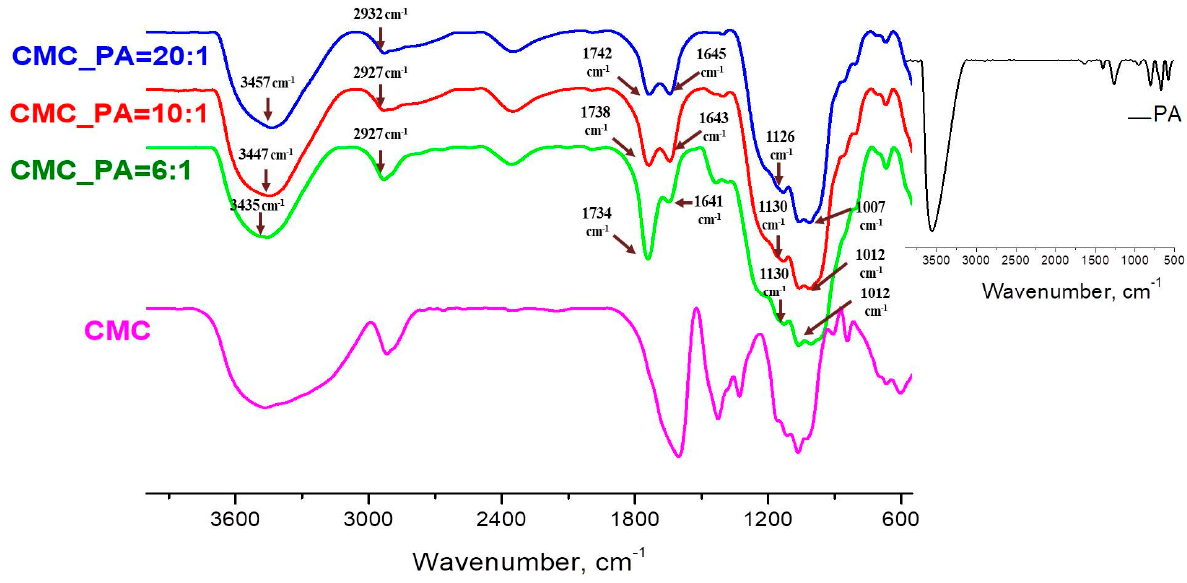
Figure 2. FTIR spectra of the hydrogels of CMC/PA and pure CMC; the spectrum of PA can be found in the insert.